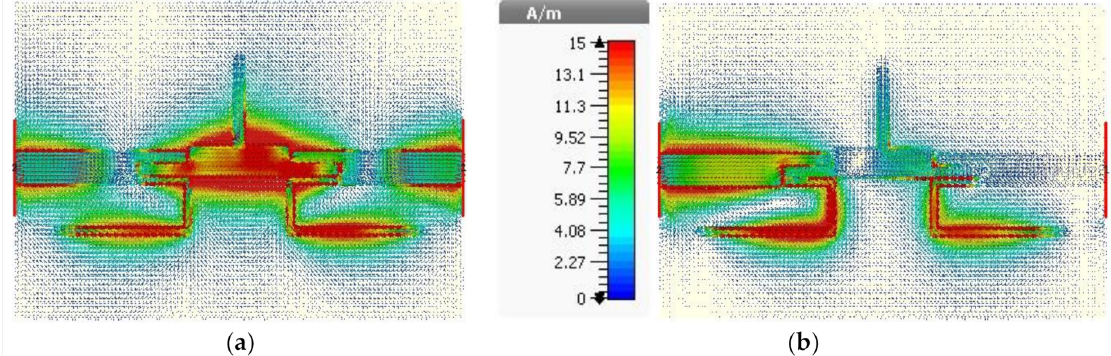
Figure 6. The current distribution of the proposed filter: ( a ) outside the transmission zero (f = 3.9 GHz); and ( b ) at the created transmission zero (f = 3.24 GHz).